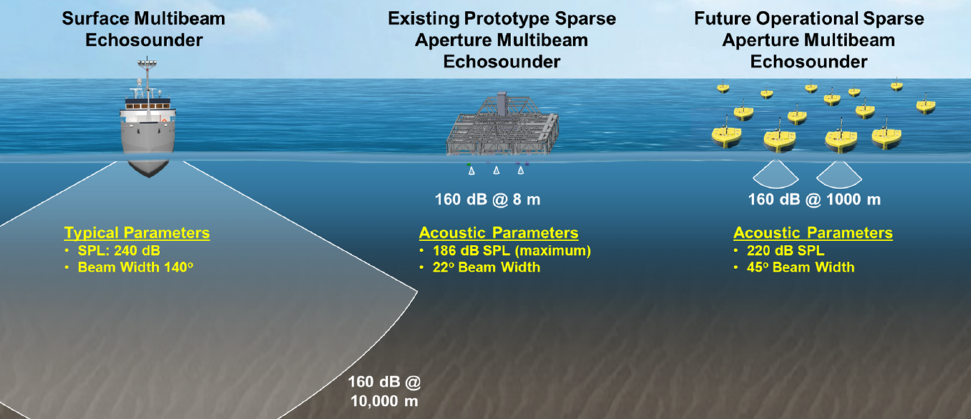
Figure A1. Approximate distance from acoustic sources that exceed 160 dB sound pressure level for a typical ship-based multibeam echosounder, our existing prototype array, and a future first-generation operational